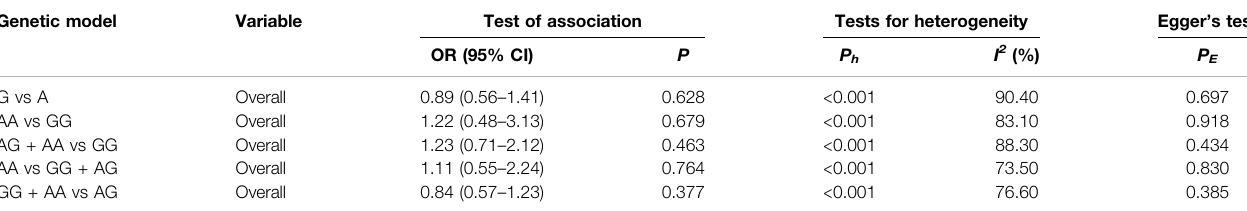
TABLE 11 | Pooled estimates of association of VDR Cdx2 polymorphism and the risk of osteoporotic fracture. Genetic